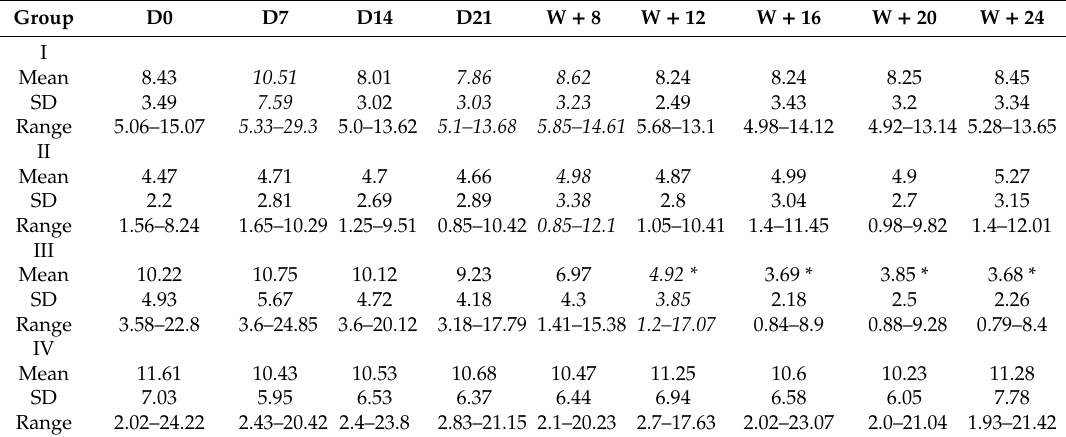
Table 6. Testicular volume (v, cm 3 ) in control I and II, and study III and IV groups in the following examinations during the study. Statistical analysis in relation to day 0 (D0–D21, W + 8–W + 24, mean, SD,